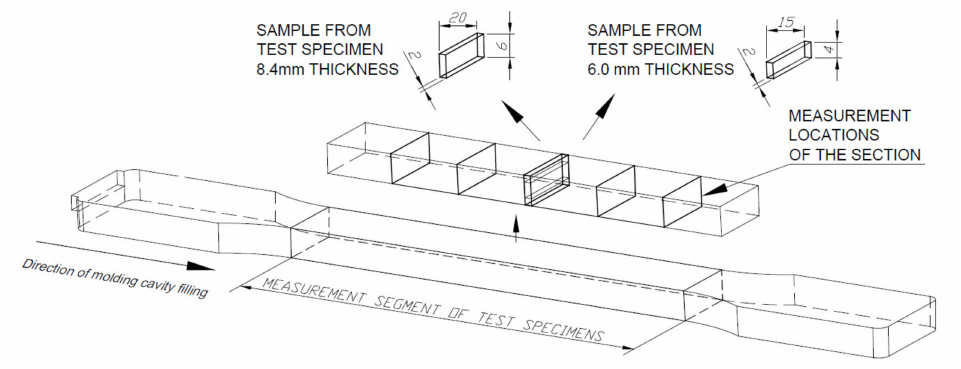
Figure 4. Sampling areas for structural analysis (all dimensions in mm).